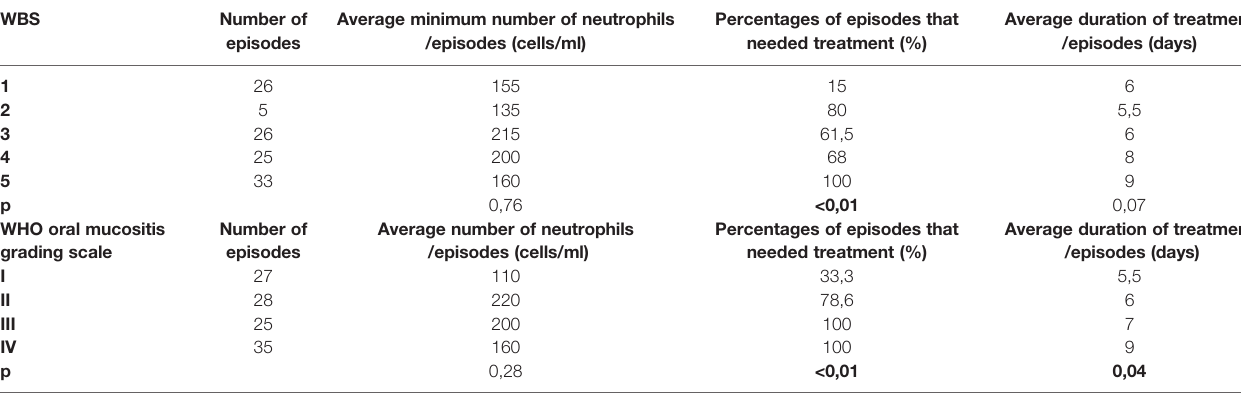
TABLE 3 | Characteristics of the mucositis episodes.